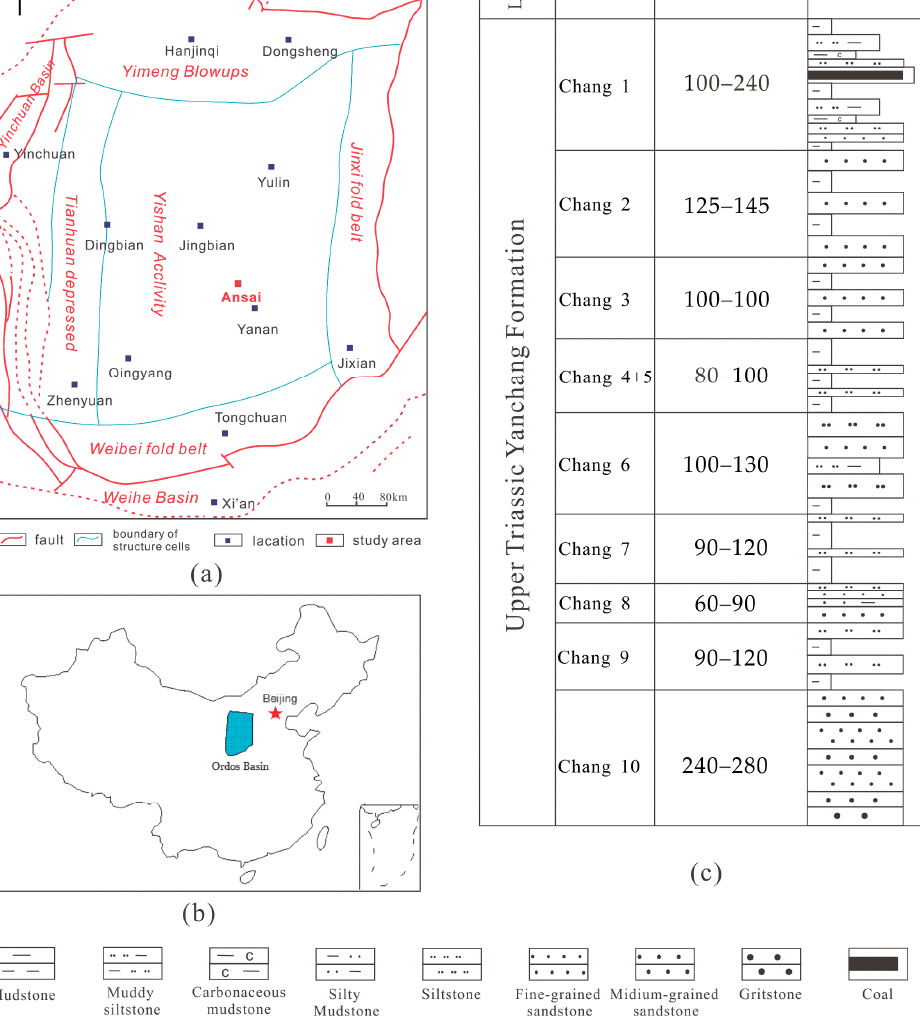
Figure 1. ( a ) Location of the study area, ( b ) location of the Ordos Basin, and ( c ) lithostratigraphic section of the Upper Triassic Yanchang Formation in the Ordos Basin [20,40] .